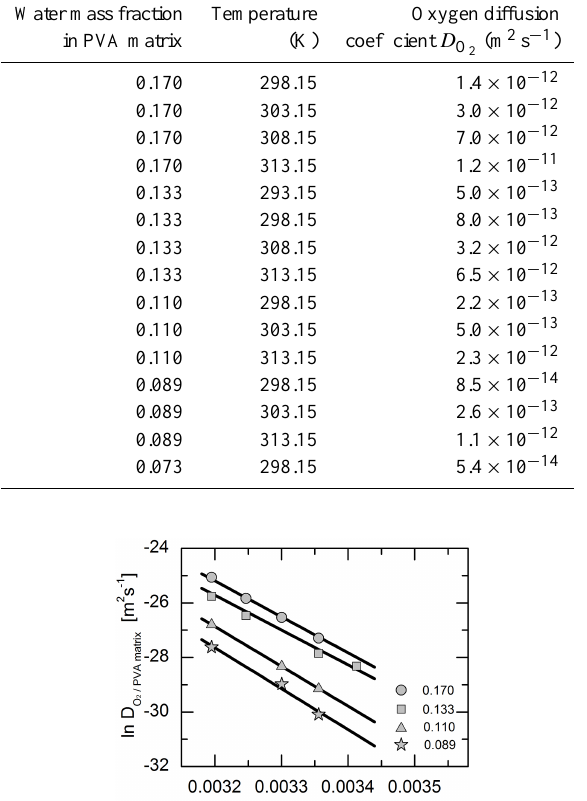
Table 2. Oxygen diffusion coefficients in a PVA matrix as a func- tion of water mass fraction in the PVA matrix and of temperature.